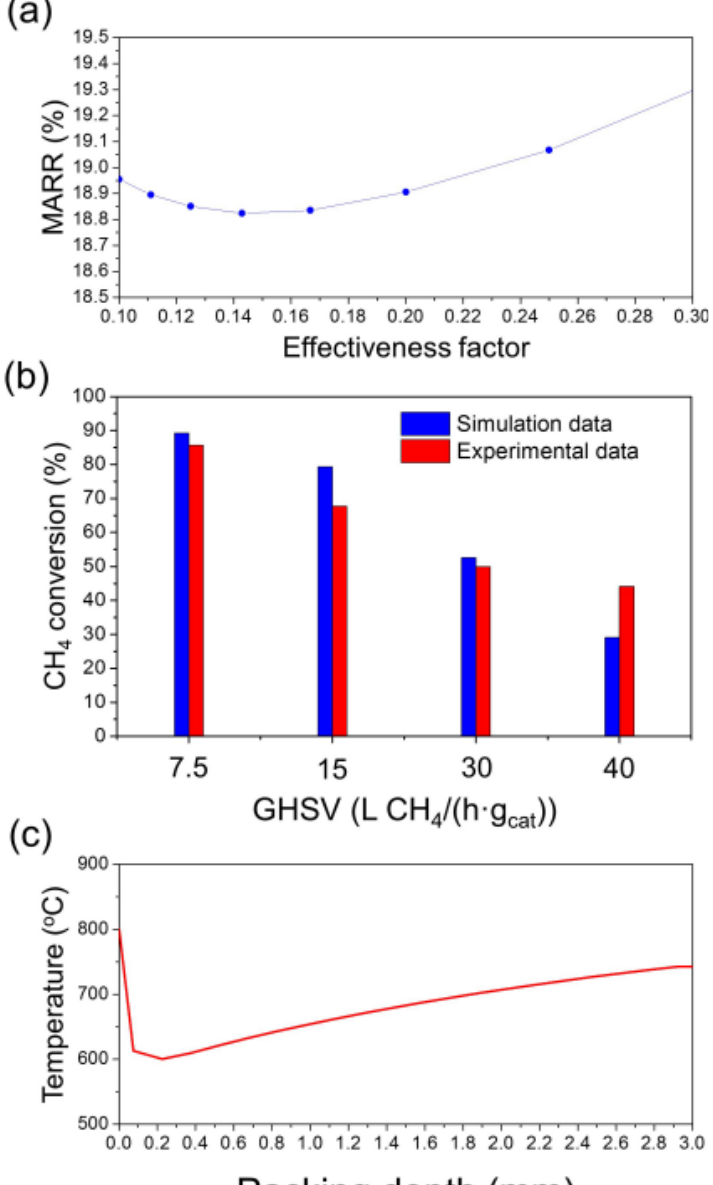
Figure 7. ( a ) Mean of absolute relative residuals (MARRs) values with respect to the overall effectiveness factor, ( b ) comparison of CH 4 conversion for various space velocities [mL CH 4 /(h·g cat )], ( c ) temperature profile in the reactor at 7500 mL CH 4 /(h·g cat ). Wall temperature = 800 °C, pressure = 0.6 MPa, overall heat transfer coefficient = 100 W/m 2 ·K, and feed composition of CH 4 /H 2 O/N 2 = 1/3/1.